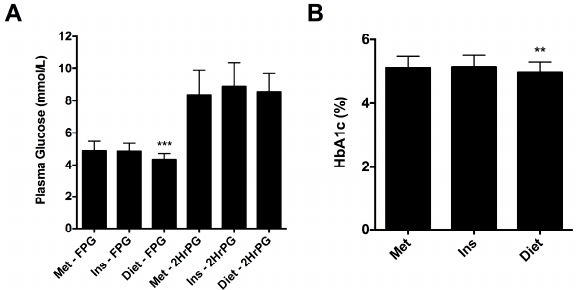
Figure 1. ( A ) Fasting plasma glucose (FPG) and 2-hour plasma glucose post 75 g oral glucose tolerance test (OGTT) (2HrPG) for women diagnosed with GDM that were subsequently managed with metformin (Met), insulin (Ins) or diet and lifestyle modification (Diet). ( B ) HbA1c at diagnosis of GDM for women subsequently treated with metformin, insulin or diet and lifestyle modification. Results expressed as mean ± standard deviation. ** p < 0.01; *** p < 0.0001.